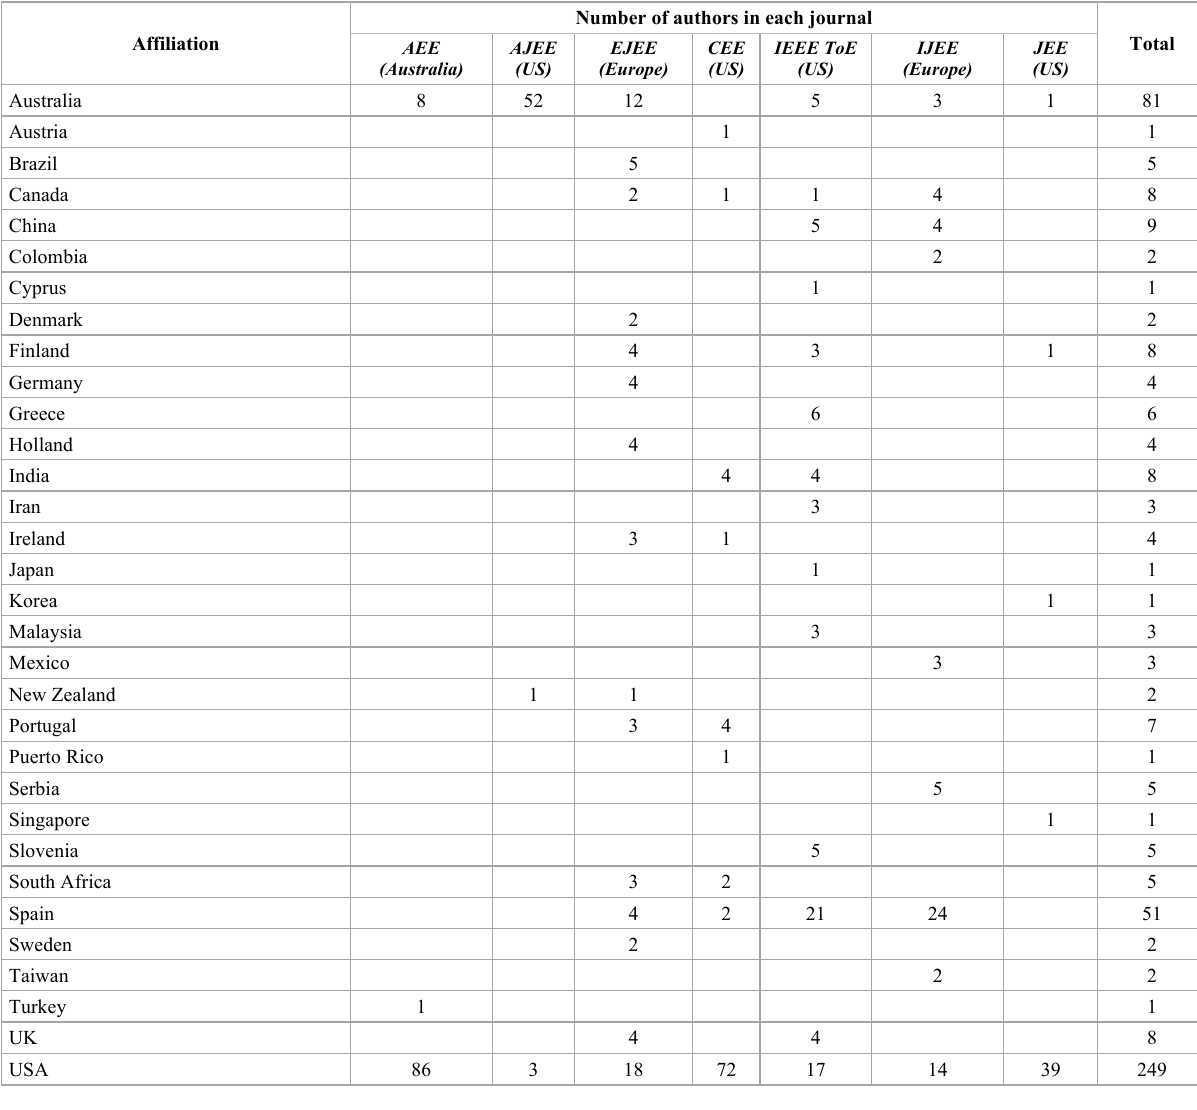
TABLE VI. G EOGRAPHICAL ORIGIN OF AUTHORS BASED ON AFFILIATION ANALYSIS